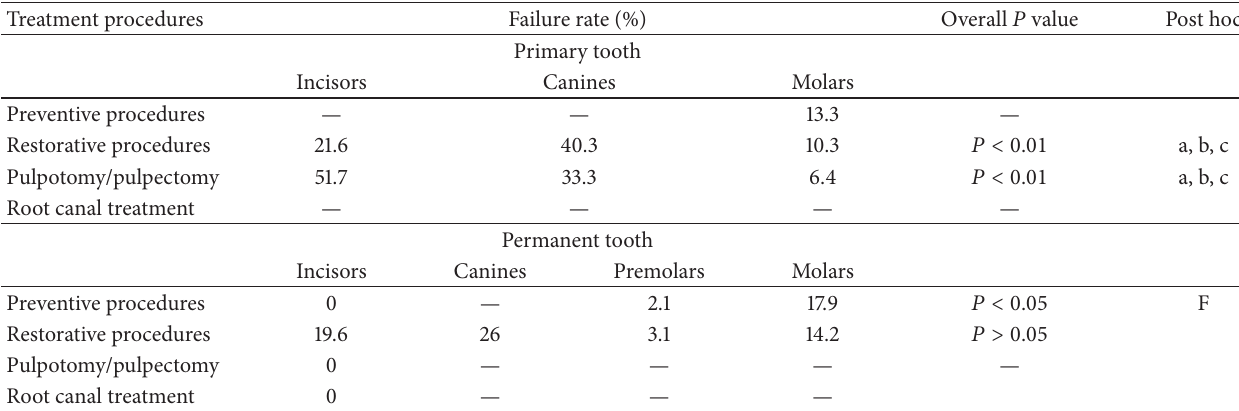
Table 3: Failure rates of different treatment procedures by tooth type.